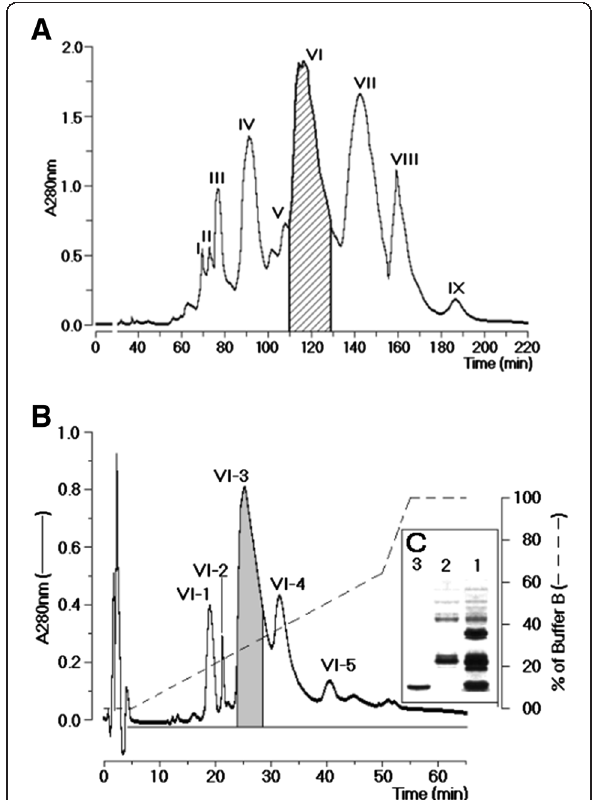
Figure 1 Fractionation of AmV. (A) Chromatography of whole protein extract from honeybee venom using a molecular exclusion column packed with Superdex®75. The chromatographic run was carried out at a flow rate of 0.6 mL/h and monitored at 280 nm. (B) Reverse phase HPLC run yielded five main fractions designated from VI-1 to VI-5. Fraction VI-3 was confirmed as PLA 2 by specific phospholipase A 2 assay and fraction VI-4 as melittin after MALDI-TOFF analysis. (C) SDS-PAGE analysis of the purified